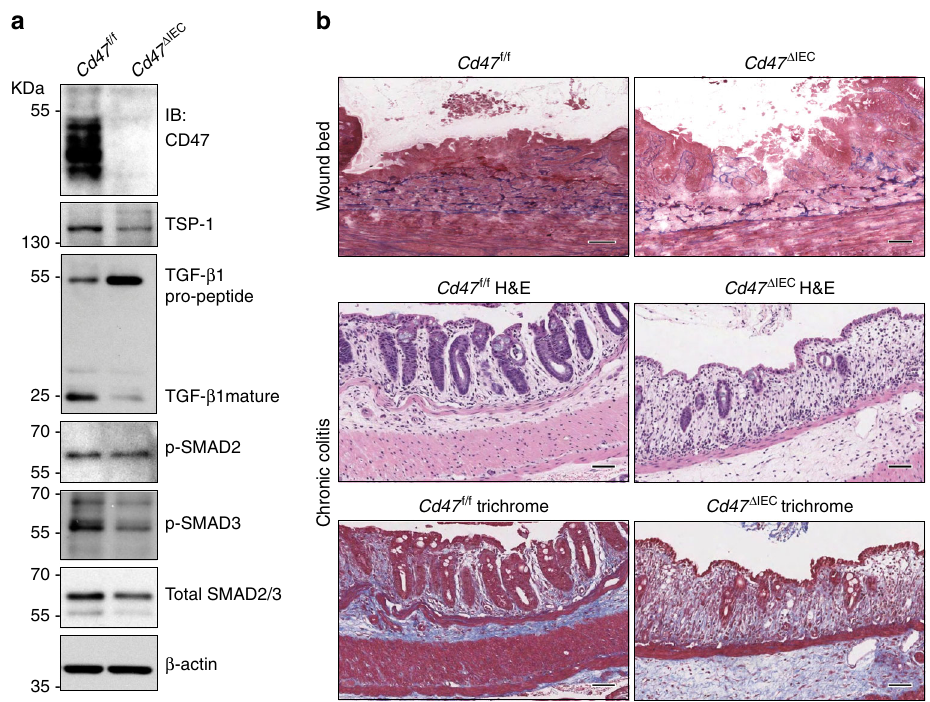
Fig. 7 CD47 regulates thrombospondin-1, TGF- β 1, and collagen deposition after injury. a Whole cell lysates from freshly isolated intestinal epithelial cells from Cd47 f/f and Cd47 Δ IEC mice were subjected to SDS – PAGE and immunoblot for thrombospondin-1/TSP-1, TGF- β 1, and phosphorylated SMAD2 and SMAD3. Results are representative of three independent experiments. b Representative Masson ’ s trichrome staining of wounds beds and chronic DSS- colitis colons from Cd47 f/f and Cd47 Δ IEC mice. Scale bars = 50 μ m. Results representative of three independent experiments with 5 – 7 mice per group. Source data are provided as a Source Data fi